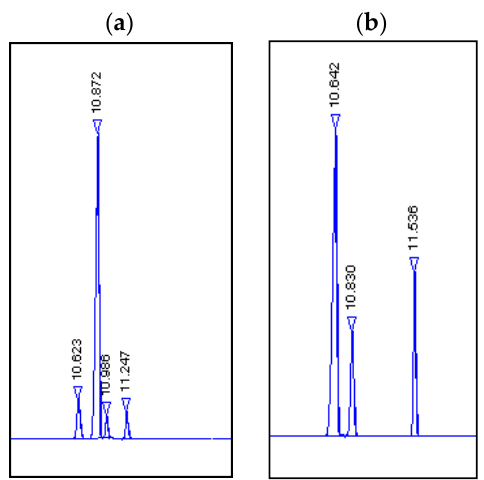
Figure 5. Chromatograms. ( a ) Products obtained by biotransformation using potato: R f =10.623, (1 S ,4 S )-dihydrocarvone ( 8 ); R f =10.872 (1 R ,4 S )-dihydrocarvone ( 7 ); R f =10.986 dihydrocarveol ( 9 ); R f =11.247 dihydrocarveol ( 10 ). ( b ) Standards: R f =10.642, (1 S ,4 S )-dihydrocarvone, R f =10.830, (1 R ,4 S )-dihydrocarvone; R f =11.536 (4 S )-(+)-carvone ( 6 ).